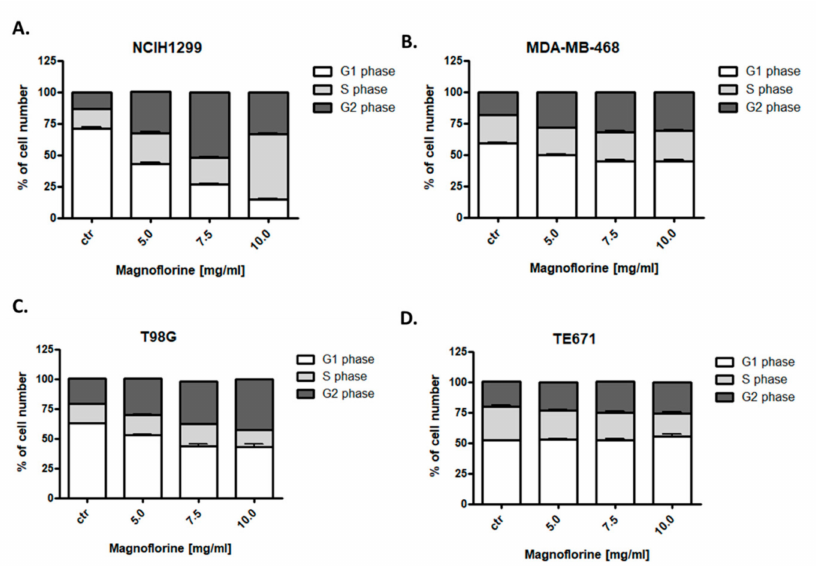
Figure 7. E ff ects of magnoflorine (MGN) on the cell cycle progression in NCIH1299 lung ( A ), MDA-MB-468 breast ( B ), T98G glioma ( C ), and TE671 rhabdomyosarcoma ( D ) cancer cells. Cancer cell lines were cultivated for 48 h with di ff erent doses of magnoflorine (5–10 mg / mL) and analyzed by flow cytometry. The results are depicted as means ± SD, n = 9 from three separate